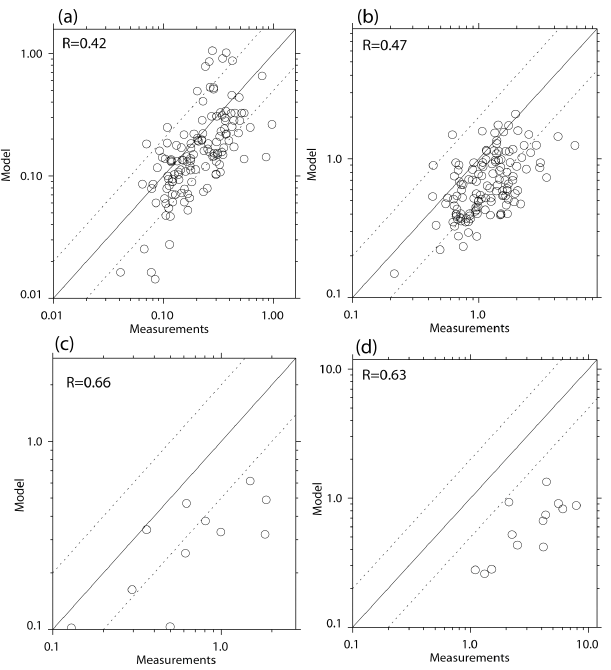
Fig. 3. Comparison of simulated annual average surface concentra- tions (µgm − 3 ) with the IMPROVE surface monitoring network for remote locations in the United States (average of 2002 and 2003) for (a) BC and (b) OC (includes SOA), and with the EMEP sur- face monitoring network for Europe (average for July 2002 to June 2003) for (c) BC and (d) OC (includes SOA). Dashed lines repre- sent the 1:2 and 2:1 lines indicating agreement within a factor of